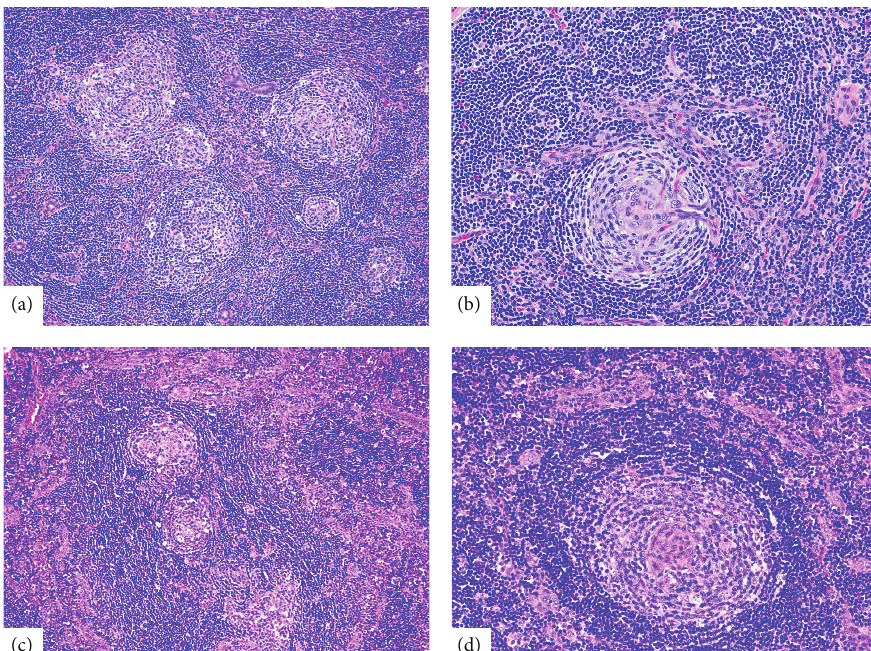
Figure 3: Representative microscopic images from case 1 (a and b) and case 2 (c and d). (a) Predominant lymphoid tissue surrounding variably sized salivary gland ducts. (b) Sclerotic vessels focally penetrating a geminal center, creating a “lollipop lesion.” (c) Lymphoid tissue with abnormal follicular centers. (d) A follicle with a targetoid arrangement of mantle lymphocytes and marked vascular proliferation and hyalinization in germinal center. Hematoxylin-eosin stain; original magnification: 100x for (a) and (c) and 200x for (b) and